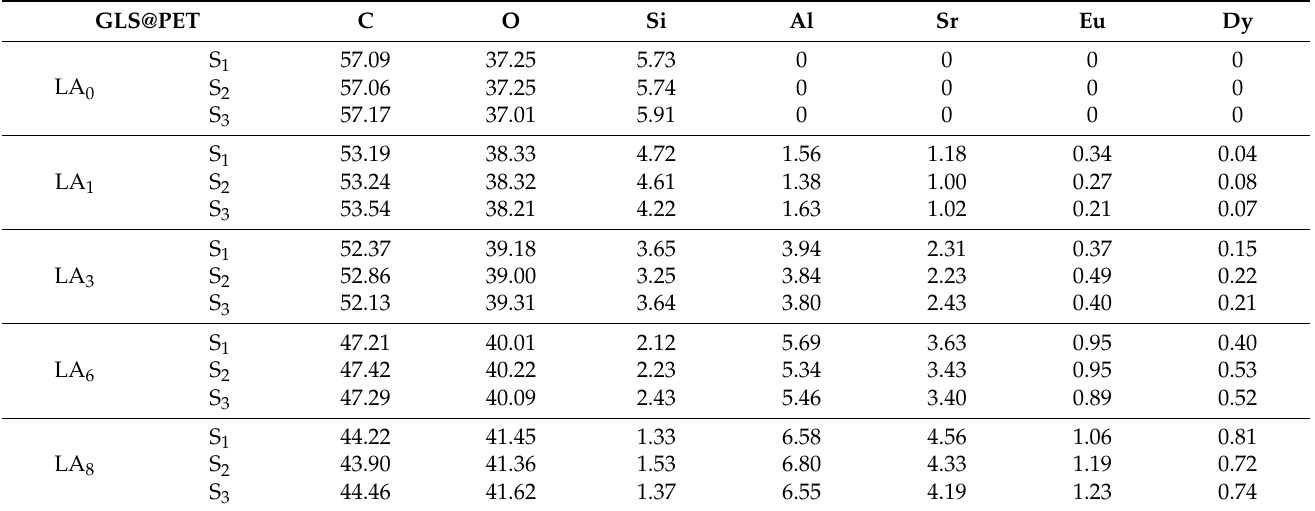
Table 1. Elemental compositions (wt%) of LANPs-free and LANPs-loaded GLS@PET nanocomposites as detected by EDXA at three positions (S 1 , S 2 and S 3 ) on the GLS@PET surfaces.